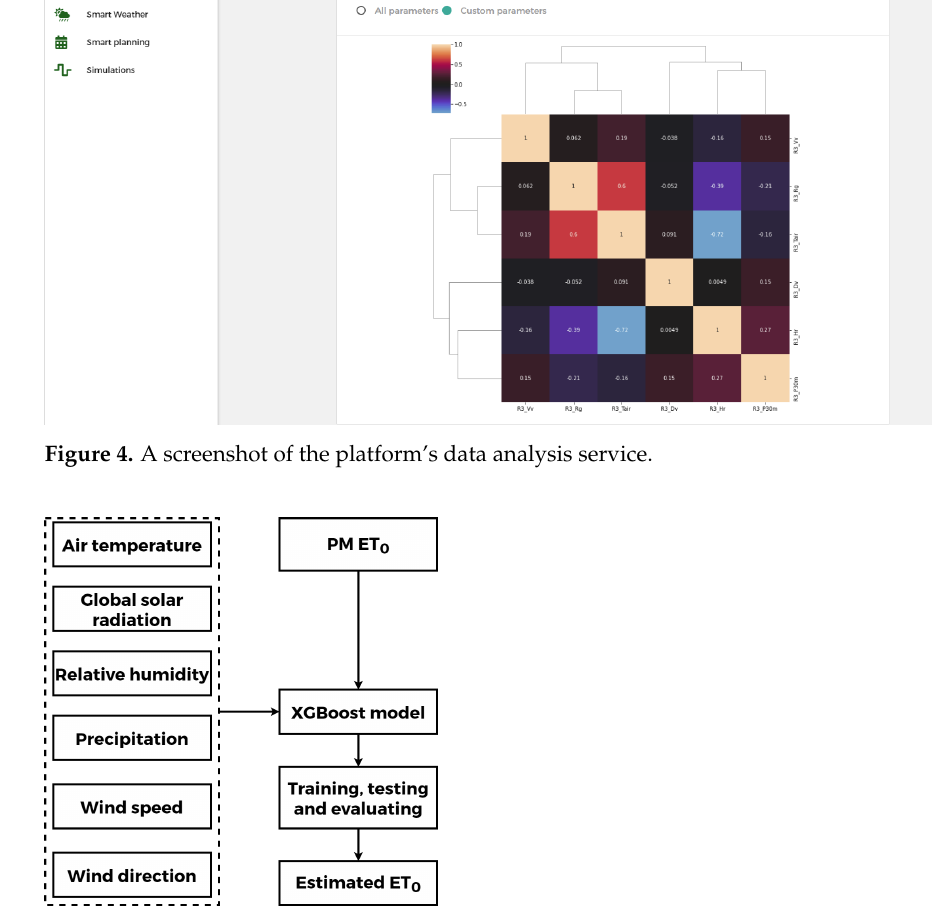
Figure 5. The flowchart of ET 0 estimating using machine learning.